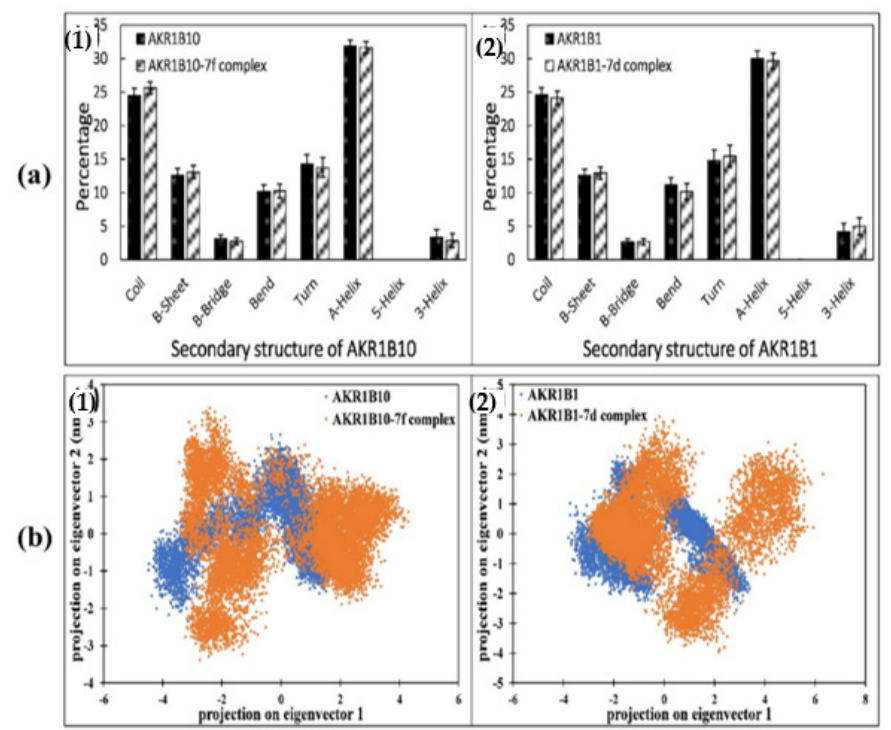
Figure 9. ( a1 ) Map of 7f ’s hydrogen bonds in complex with AKR1B10 during MD simulation. ( a2 ) Map shows the presence of hydrogen bonds in 7d in complex with AKR1B1 during MD simulation. ( b1 ) The two-dimensional scatter plot of PCA obtained by projecting the AKR1B10 and AKR1B10 − 7f complex eigenvectors. ( b2 ) Two-dimensional scatter plot of PCA obtained by projecting the AKR1B1 and AKR1B1 − 7d complex eigenvectors.